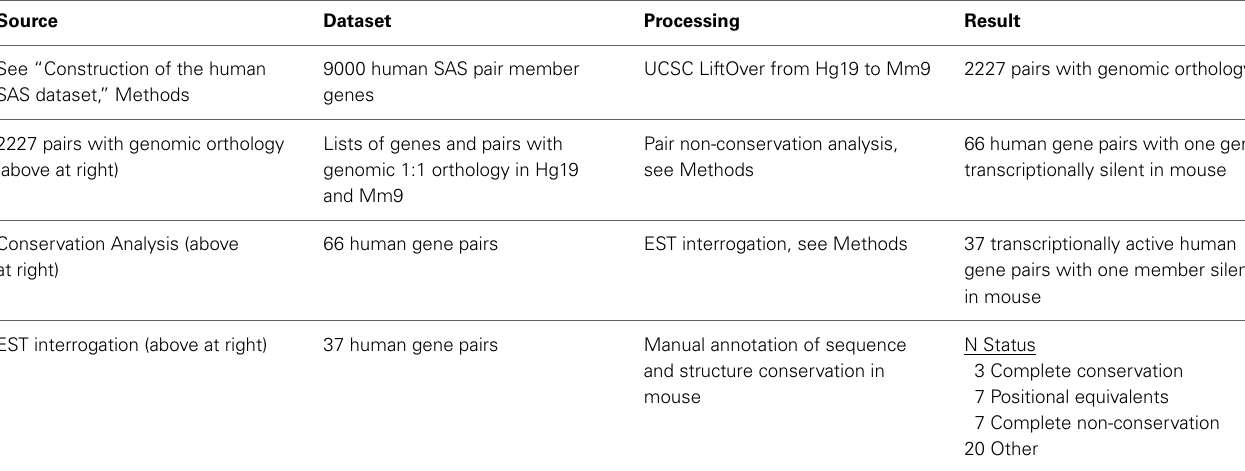
Table 1 | Human-mouse comparative analysis of genomic and transcriptomic orthology at sense-antisense loci.